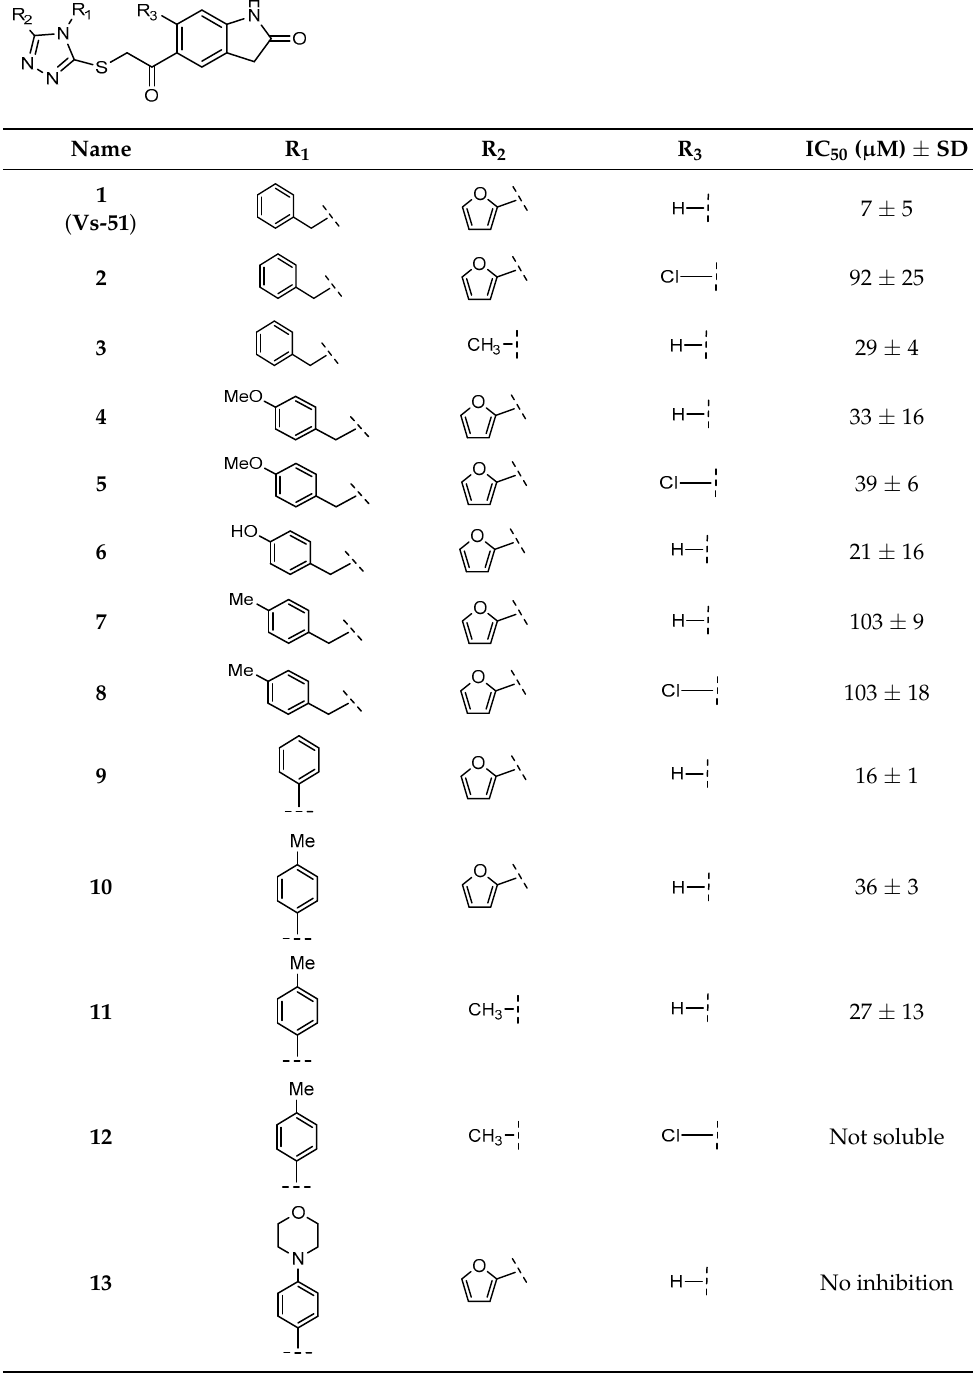
Table 2. Results of IC 50 measurements for the resynthesized hit Vs-51 ( 1 ) and its derivatives ( 2–13 ). C 50 values were measured by a fluorescence-based transferase activity assay in two independent experiments. OSMI-4b (ester form) was used as a positive control (IC 50 = 0.06 ± 0.02 µM, Table 1).